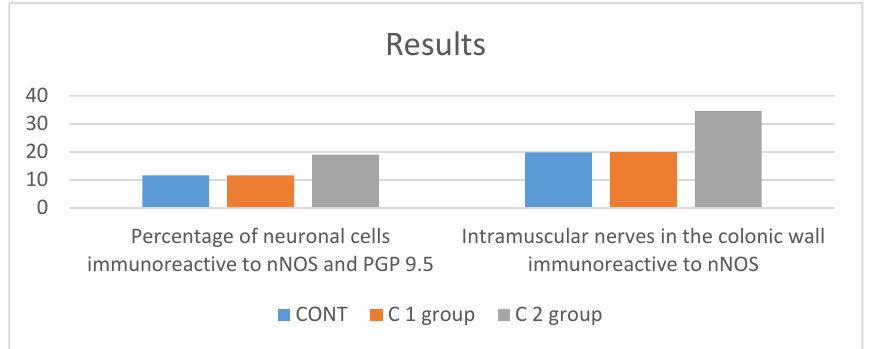
Figure 1. The percentage of neuronal cells nNOS/PGP 9.5 positive and the percentage of nitric oxide synthase (nNOS) immunoreactive fibers in the colonic wall in the control group (blue column), C1 group (orange column), and C2 group (grey column).